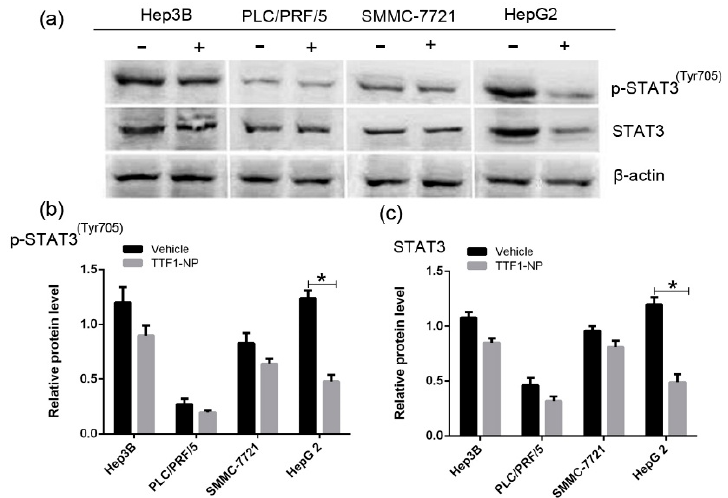
Figure 3. TTF1-NP downregulated expression of STAT3 and p-STAT3 in different HCC cell lines. ( a ) Western blot assays the expression of STAT3 and p-STAT3 in different HCC cell lines; ( b , c ) Quantification of western blot analysis of ( b ) p-STAT3 and ( c ) STAT3 levels normalized by the levels of β -actin. Data represent mean ± SD of three independent experiments. * p < 0.05 for the designated treatment vs. Vehicle.